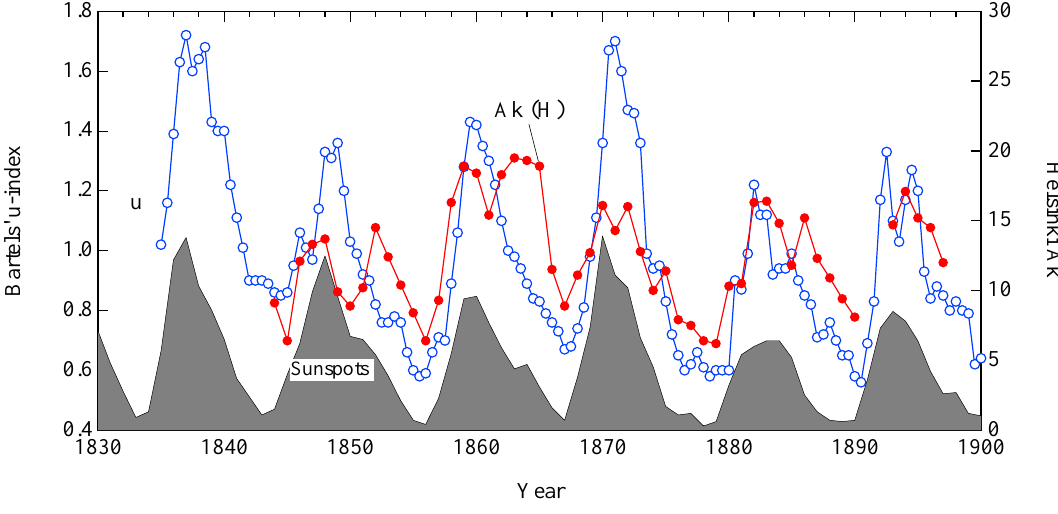
Fig. 6. Annual means of Helsinki Ak(H) and Bartels’ mid-latitude activity index u . Sunspot numbers are shown at the